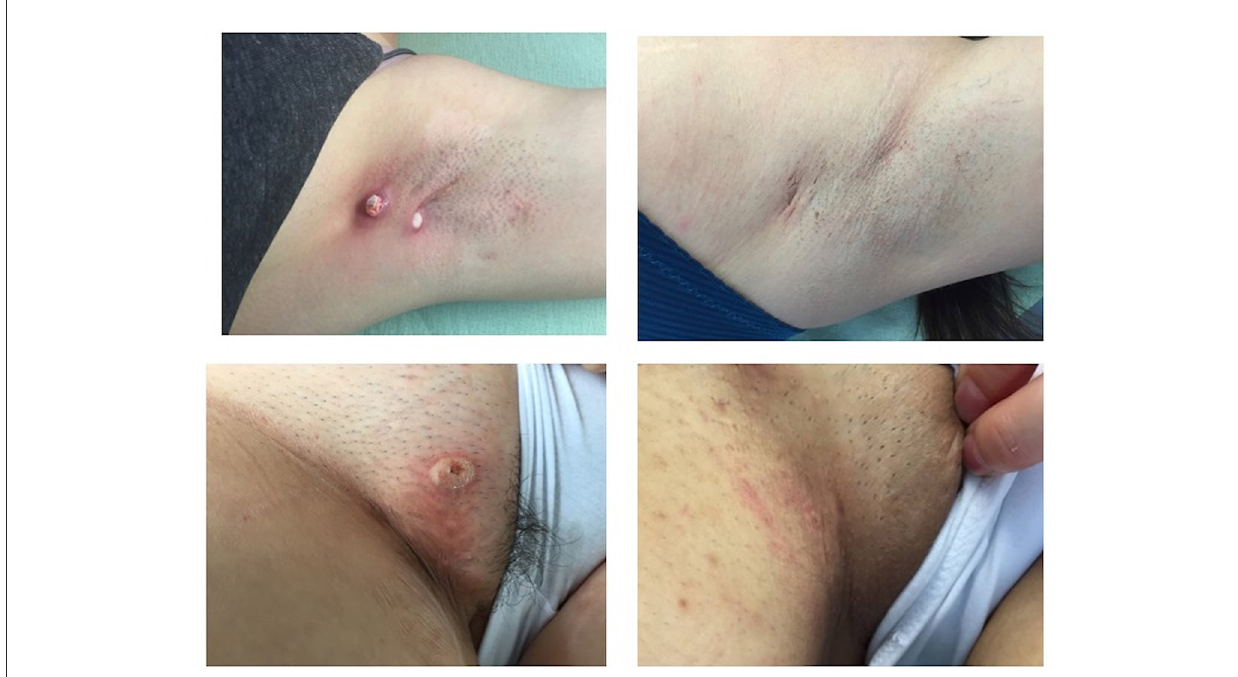
FIGURE3 Hidradenitis suppurativa lesions of the armpit and of the groin immediately after cryotherapy and complete resolution at the 6-month follow-up.